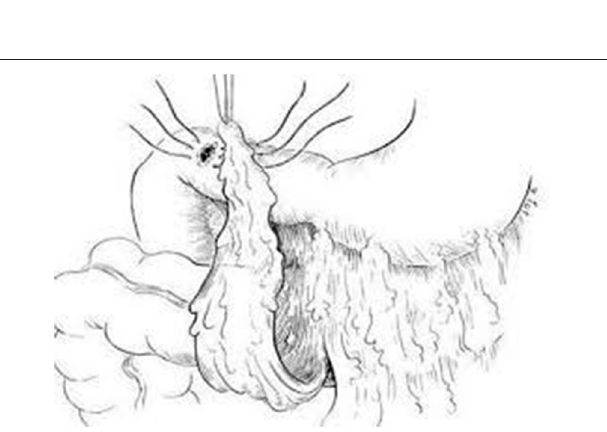
FIGURE 3 | Schematic diagram of pedicled omental flap repair of perforated duodenal ulcer.